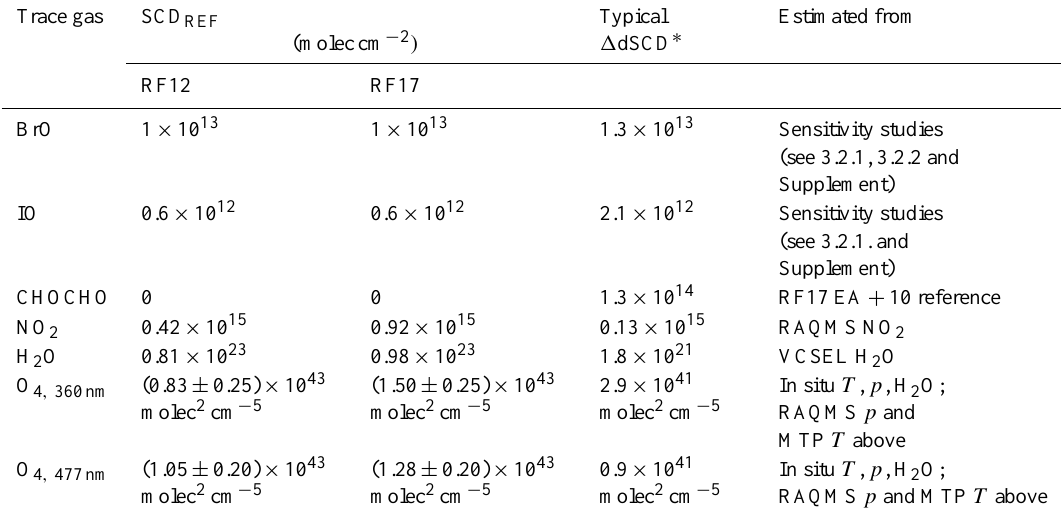
Table 3. AMAX SCD REF values and fit